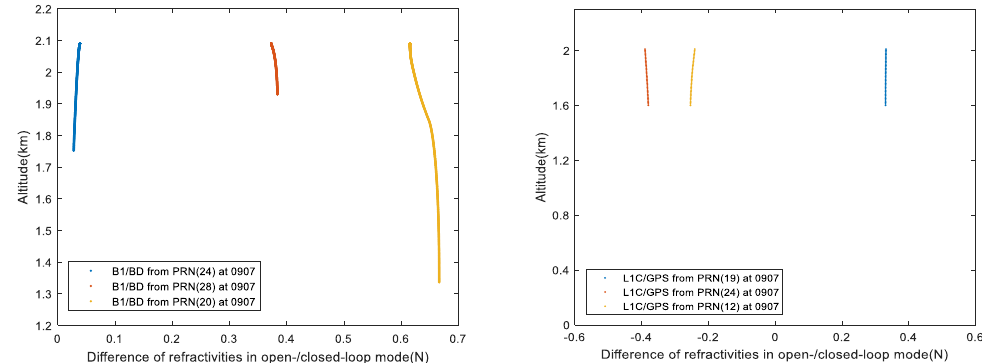
Figure 11. Di ff erence of refractivity profiles retrieved from observations of B1 / BD and L1C / GPS in Figure 11. Difference of refractivity profiles retrieved from observations of B1/BD and L1C/GPS in OL / closed-loop tracking mode. Left panel, B1 / BD; Right panel, L1C / GPS. OL/closed-loop tracking mode. Left panel, B1/BD; Right panel, L1C/GPS.